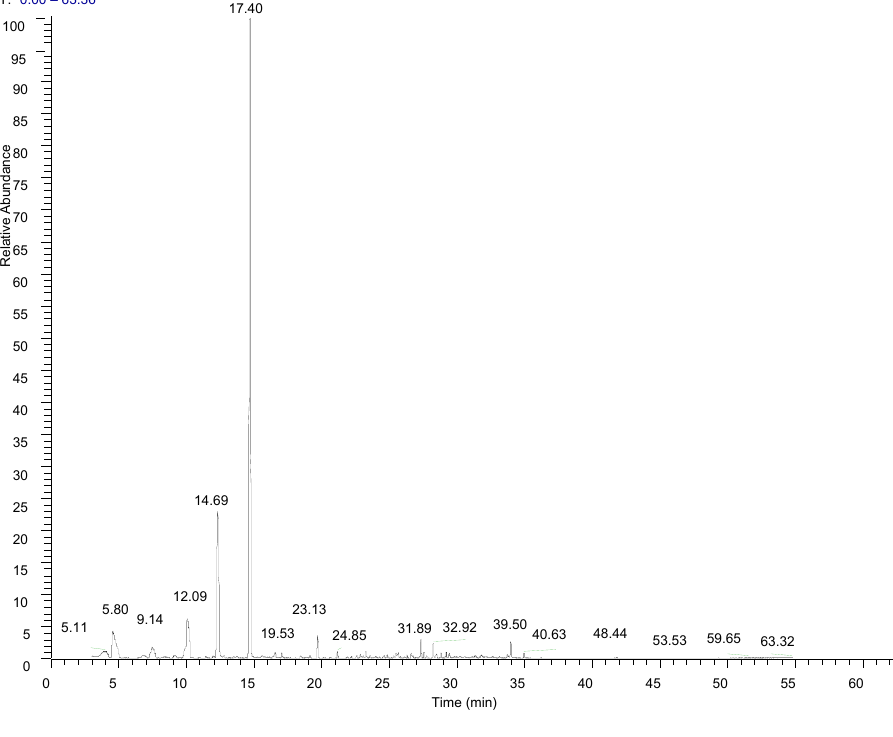
Figure 1. GC–MS chromatogram of Lavandula stoechas essential oil.